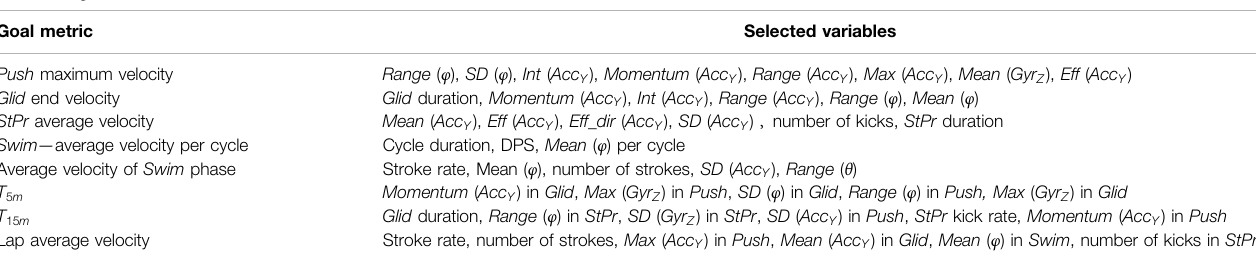
TABLE4| Theselectedvariablesforestimatingeachgoalmetricforfrontcrawltechnique,writtenintheorderofrelativeweights.Thevariablesarewrittenintheorderoftheir relative weights. For the abbreviated name of functions, see Table 2 . Goal metric Selected variables Push maximum